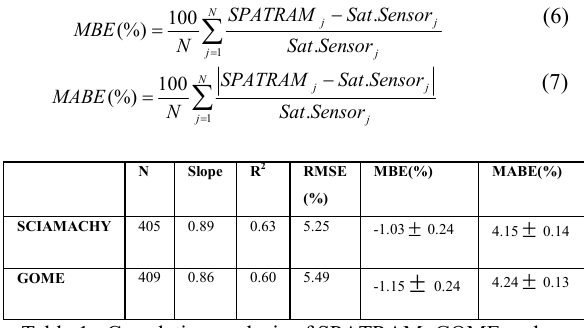
In Table 1 the Mean Bias Error (MBE) and the Mean Absolute Bias Error (MABE) are also presented which are two statistical parameters computed using Equations 6 and 7.